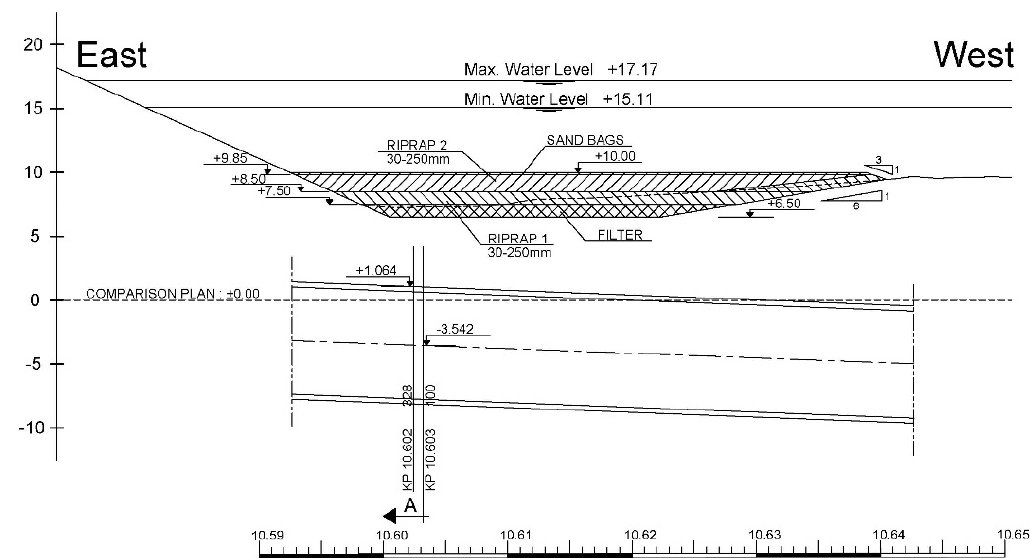
Figure 9. Longitudinal section of backfilling protection.